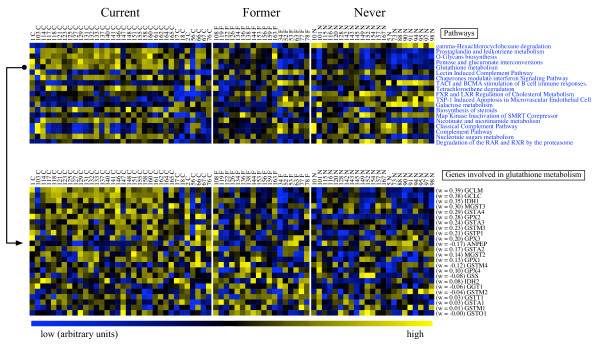
Expression profiles in airway epithelia of current (C), former (F), and never (N) smokers. Top: colormap of pathway activity levels for the highest ranking pathways in the comparison between current smokers and never smokers. Bottom: colormap for genes in the KEGG glutathione metabolism pathway. Glutathione is an important anti-oxidant known to be increased in the lungs of smokers. The genes with the highest weights in this pathway, GCLM and GCLC, encode the subunits of glutamate cysteine ligase (GCL), the rate-limiting enzyme in the synthesis of glutathione [24].